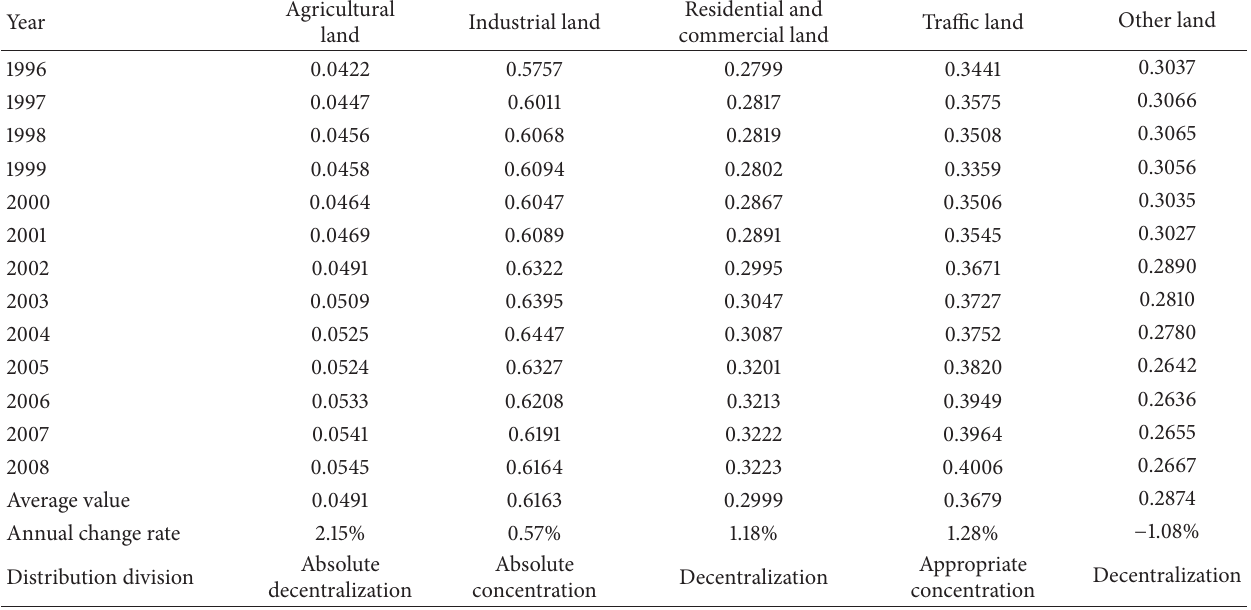
Table 4: Spatial distribution structures and divisions of different land use types.